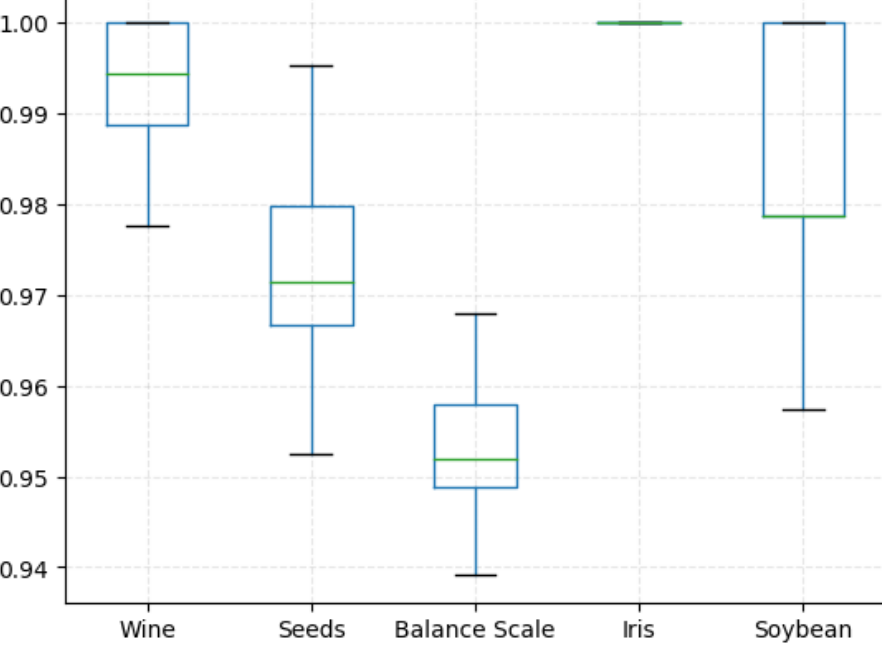
Figure 13. The distribution of the accuracy rates of the CCNN-MOEA-T algorithm tests in each datasets.